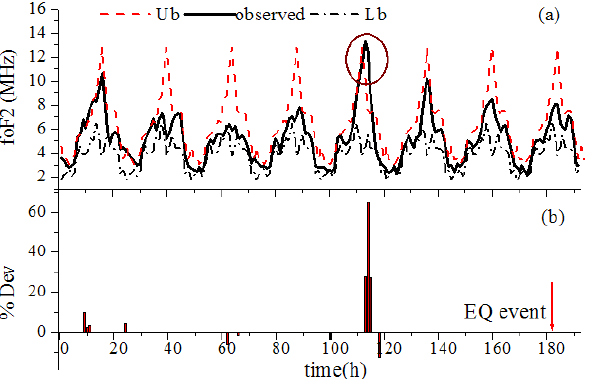
Fig. 4. Two-dimensional map for ionospheric foF2 disturbance trigged by a moderate magnetic storm at 1200 LT, on 3 May, 2008